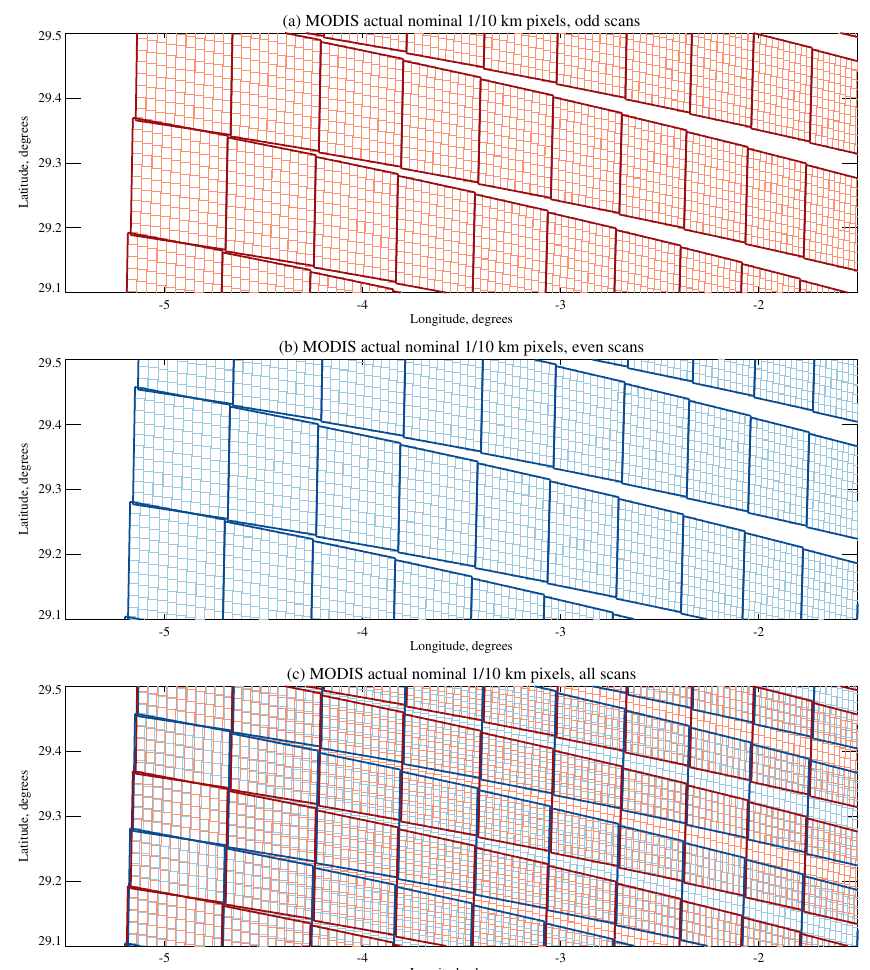
Figure 4. Borders of nominal 1km sensor pixels (pale colours) and nominal 10km retrieval pixels (strong colours) along the western edge of the granule shown in Fig. 2, illustrating the overlap between scans near swath edges. Data from alternating forward/backward scans are shown in red and blue. Panel (a) shows odd-numbered scans only, (b) even-numbered scans only, and (c) all